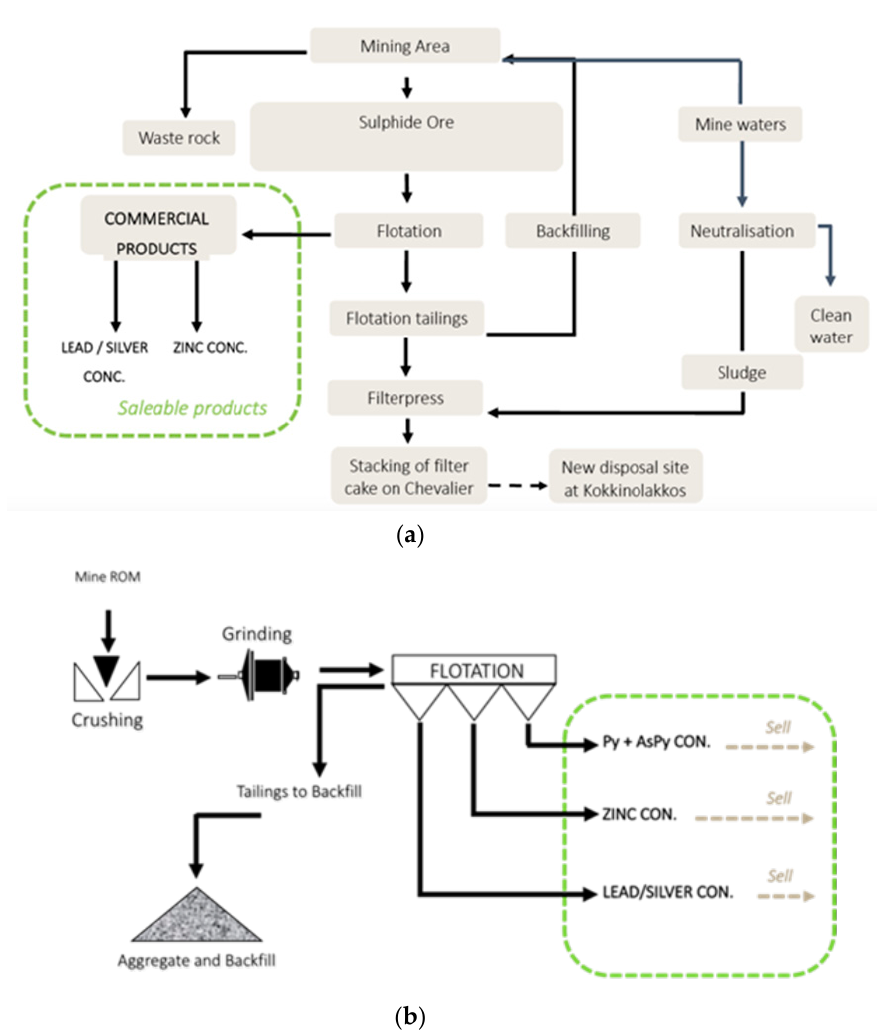
Figure 1. The current flotation plant scheme in Kassandra mines. Stratoni ( a ) and Olympias ( b ).